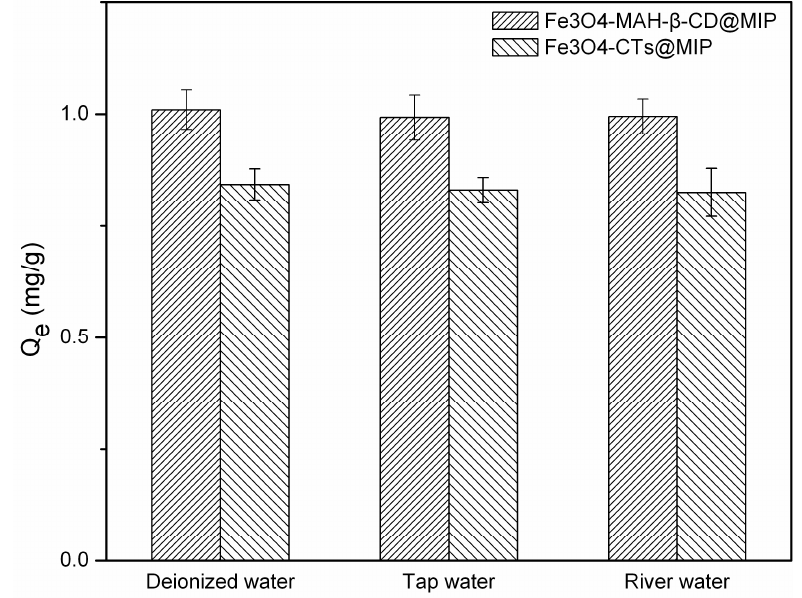
Figure 15. Removal of 2-aminopyridine from different types of real water samples.